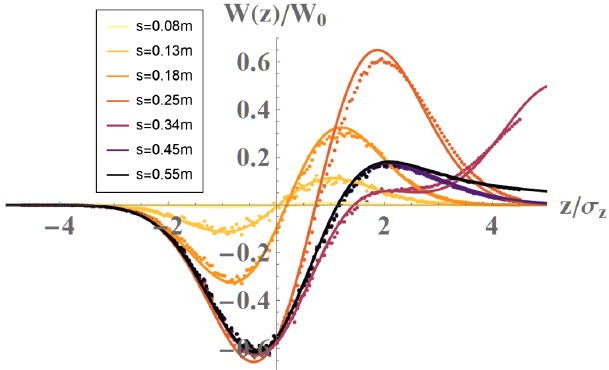
FIG. 10. Evolution of W ð z Þ inside magnet B1 in beamline A. The curves are theory prediction using Eq. (103), and the dots are from Bmad simulation. The darkest curve at s ¼ 0 . 55 m is the steady state CSR